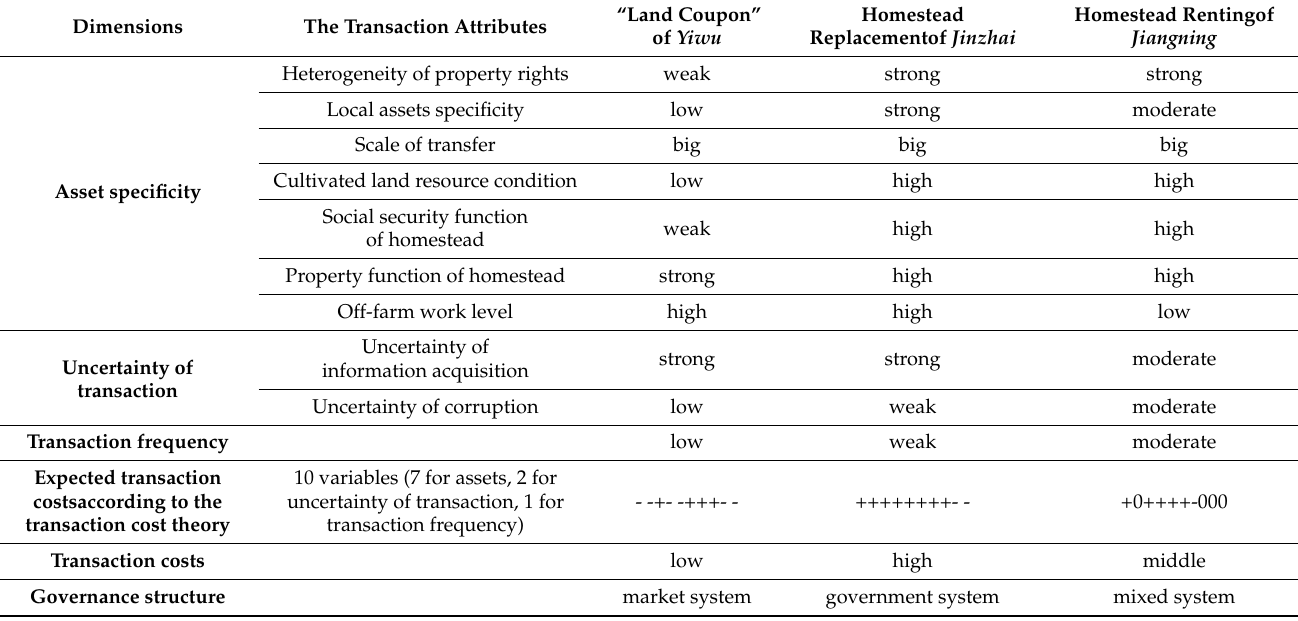
Table 2. The governance structure and the transaction attributes in the three case studies.